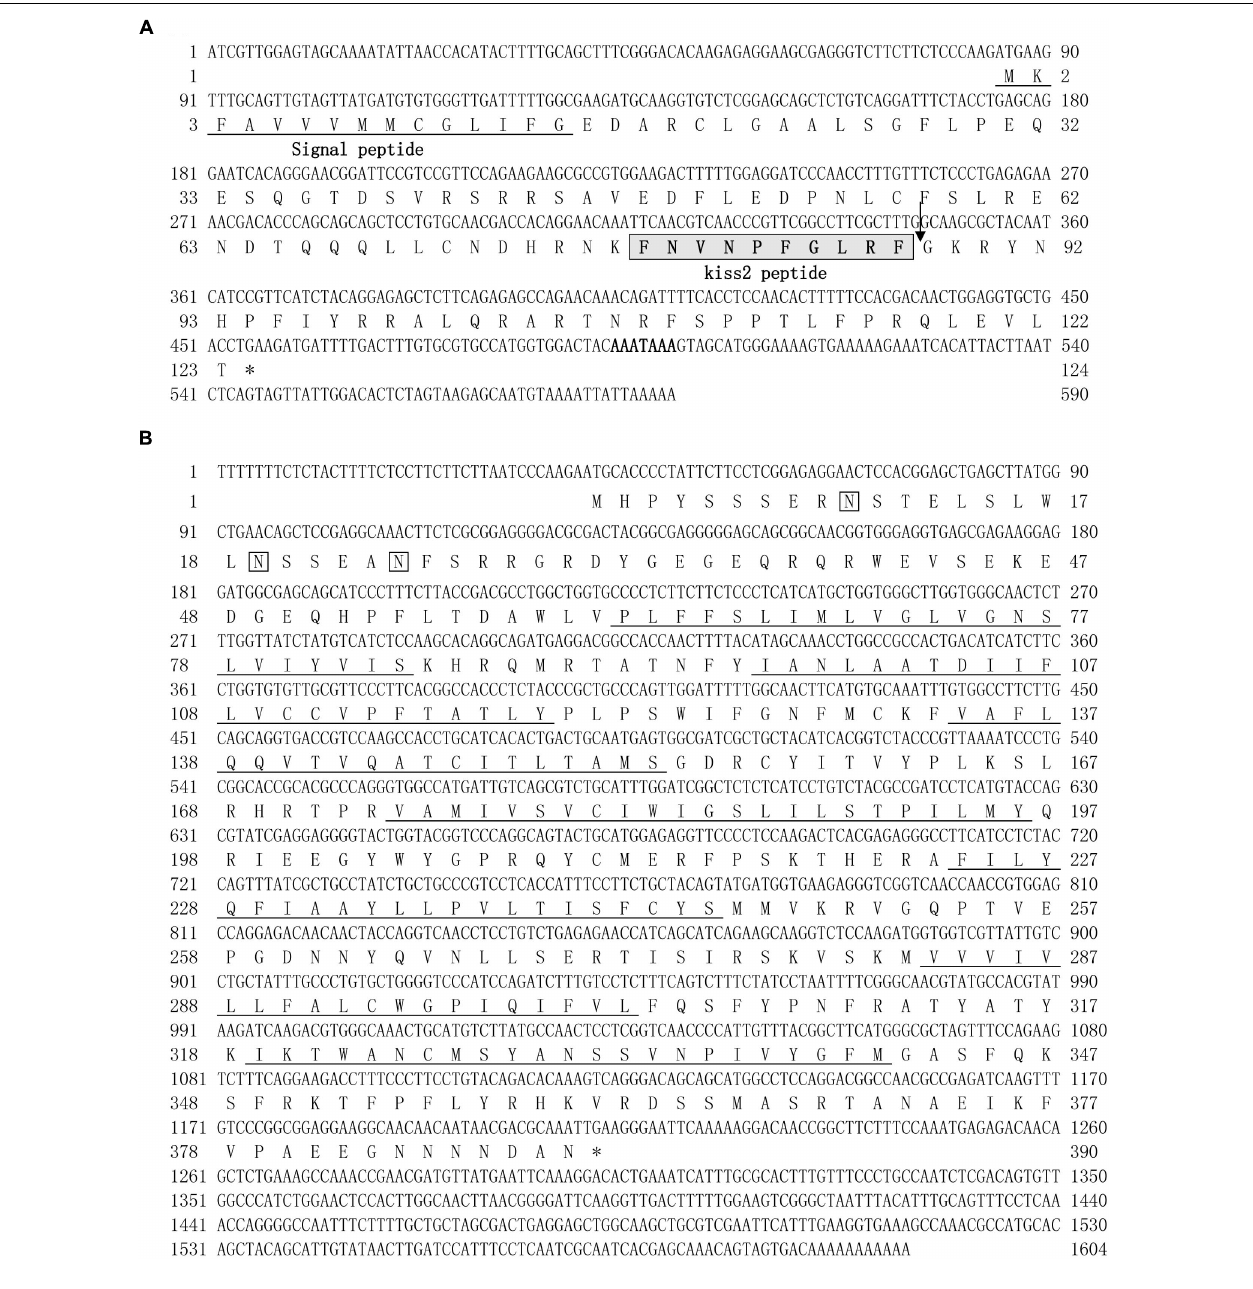
FIGURE 1 | cDNA and deduced amino acid sequence of lined seahorse kiss2 and GPR54-2. (A) The nucleotide and deduced protein sequences of kiss2 cDNA. The putative signal peptide is underlined. The mature peptide (kisspeptin-10) is boxed. (B) The nucleotide sequence and deduced protein sequence of GPR54-2 cDNA in lined seahorse. Seven putative hydrophobic transmembrane (TM) domains are underlined. Putative N-linked glycosylation sites are indicated by diamonds (CBS prediction server score >